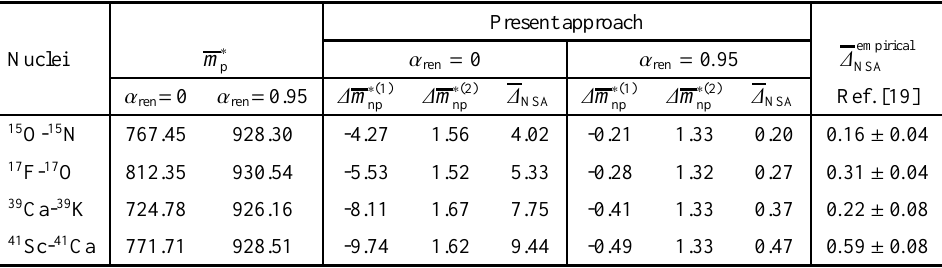
Table 2. The averaged mass m ∗ of the valence proton in a given nucleus, the contributions to the e ff ective neutron-proton mass di ff erence p (see Eq. (33)) and the Nolen-Schi ff er discrepancy ∆ NSA calculated in the present approach by Eq. (34) or Eq. (35) and the corresponding “empirical” results of Ref. [19]. All quantities are in units of MeV. Present